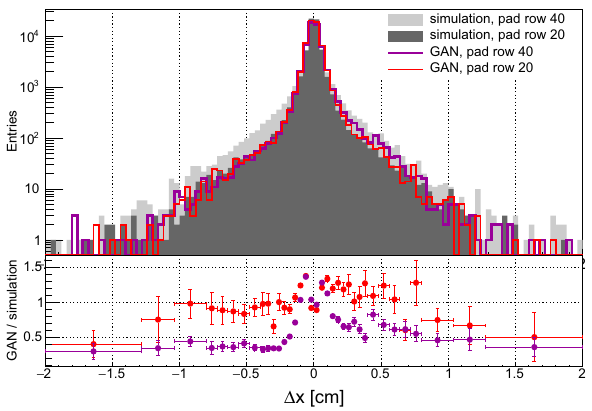
Fig. 8 Distributions of differences Δ x = x reconstructed − x true between the reconstructed and true cluster coordinates along the pad row direc- tion. For the short (long) pads from the pad row 20 (40), the detailed simulation results are shown in the dark (light) gray shaded histogram, while the histogram for the GAN prediction is shown with the red (magenta) line. The ratios between the GAN and detailed simulation yields in the same pad rows are shown in the bottom part of the